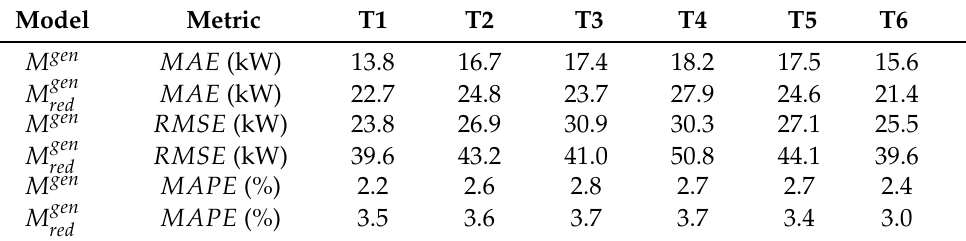
Table 3. Results of the models validation for the generator speed-power curve in Region 2.